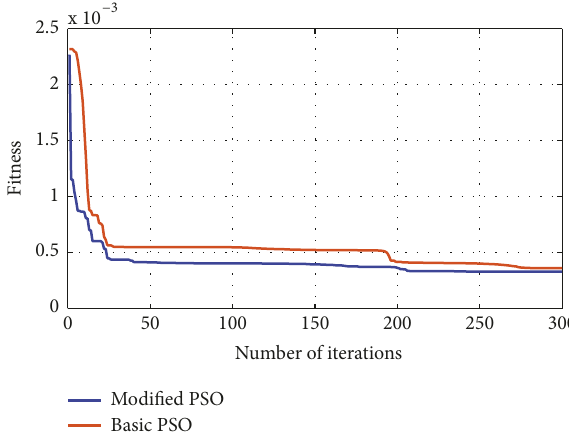
Figure 5: Comparison of fitness function between the basic PSO algorithmandthemodifiedPSOalgorithm(redline:basicPSO;blue line: modified